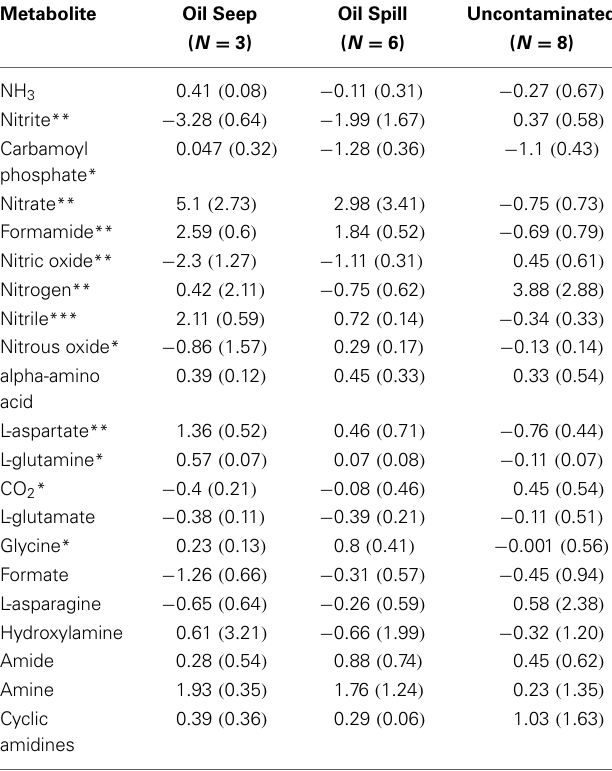
Table 2 | Nitrogen metabolism associated metabolites’ mean (and standard deviation in parentheses) PRMT